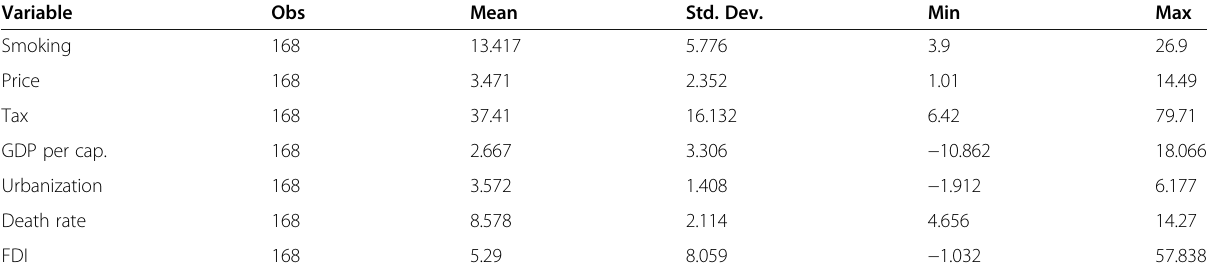
Table 3 Summary statistics of the prevalence of smoking, tobacco price, tobacco tax and control variables for all countries (2010 – 2016)